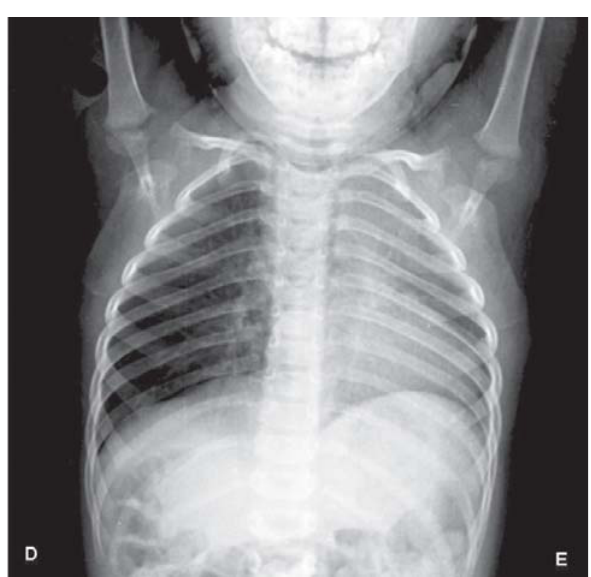
Fig. 1 – Radiografia de tórax com área cardíaca de difícil delimitação devido o desvio das estruturas mediastinais para